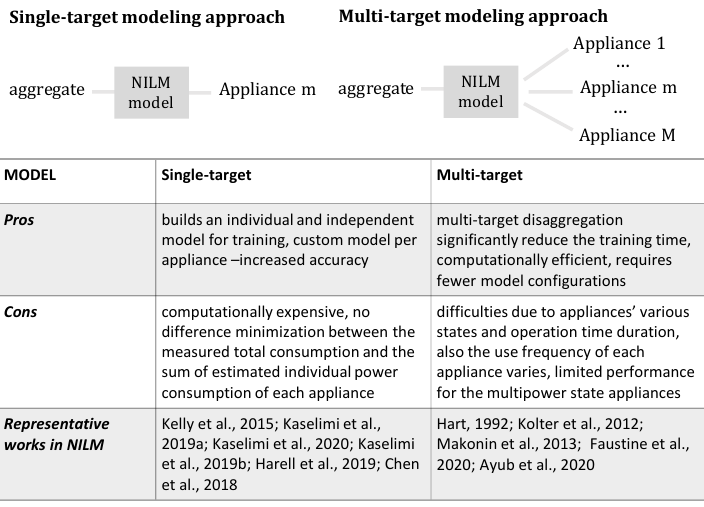
Figure 4. The single- or multi-target modeling approach dilemma in NILM [2,9,18,29,33,37,39,40,42,49,69]. Later, with the release of large amounts of datasets, supervised machine learning models that represent the nonlinear relationship between the aggregate signal and a sin- gle appliance each time (single-target model) became a method trend for solving